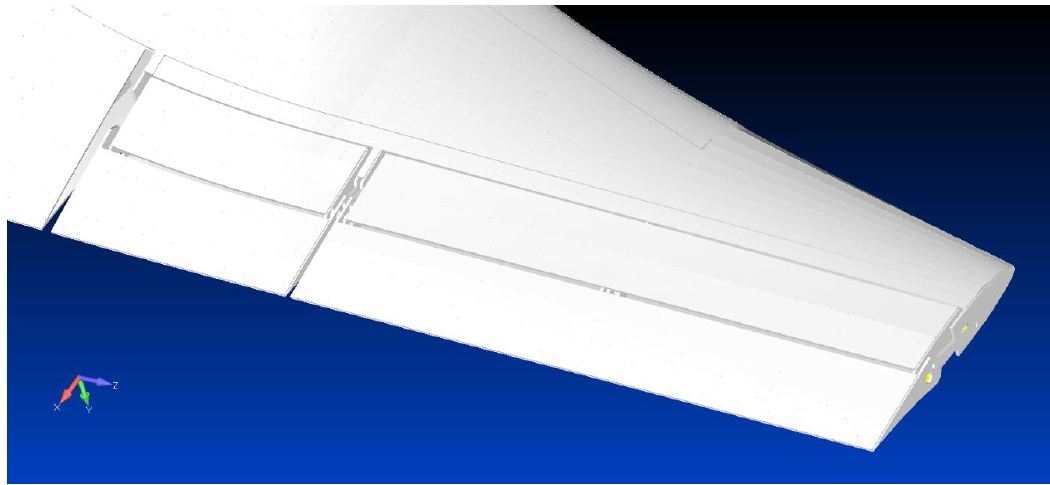
Figure 3. Segmented skin of the morphing winglet trailing edge.